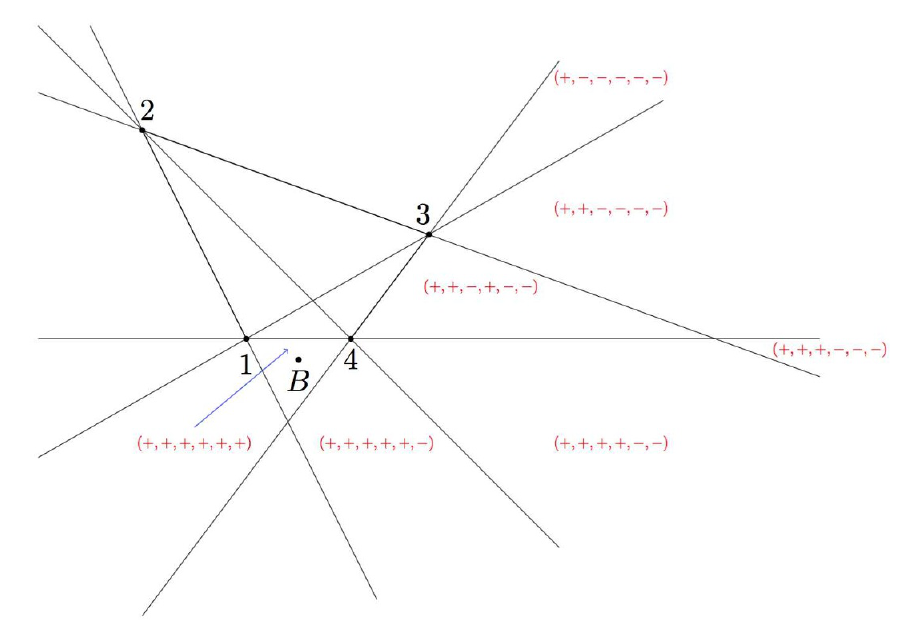
Figure 9 . Allowed regions in the projection plane for the point Z 0 of